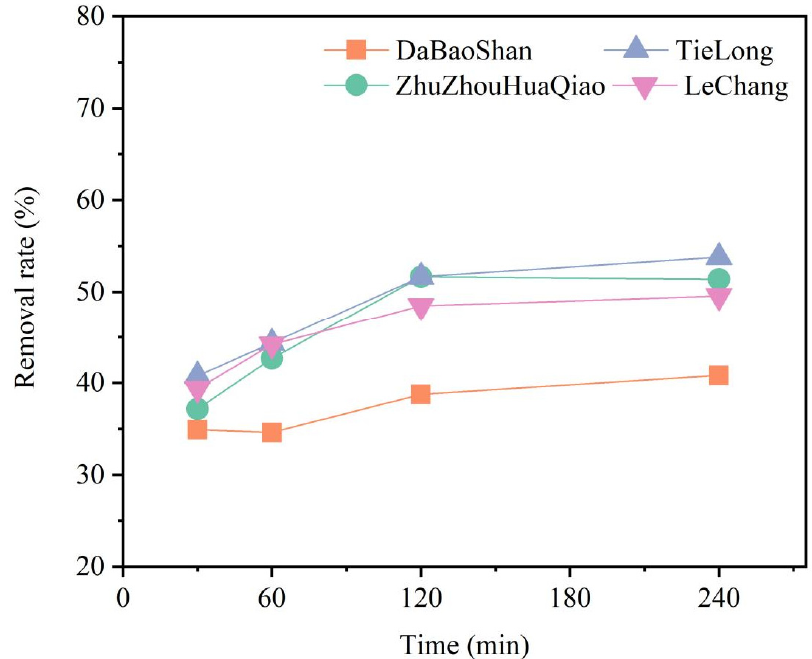
Figure 2. The change of the Pb leaching removal rate with the time of GLDA-Na with pH 4 and 5 mol/L concentration.